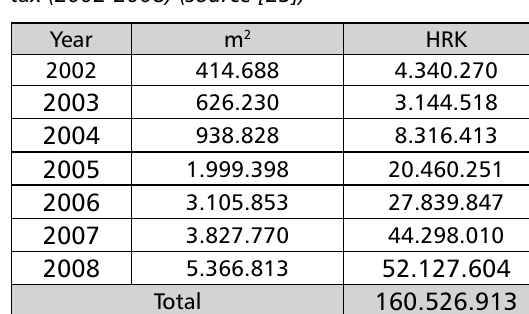
TABLE 2 Money invested in mine sweeping including green